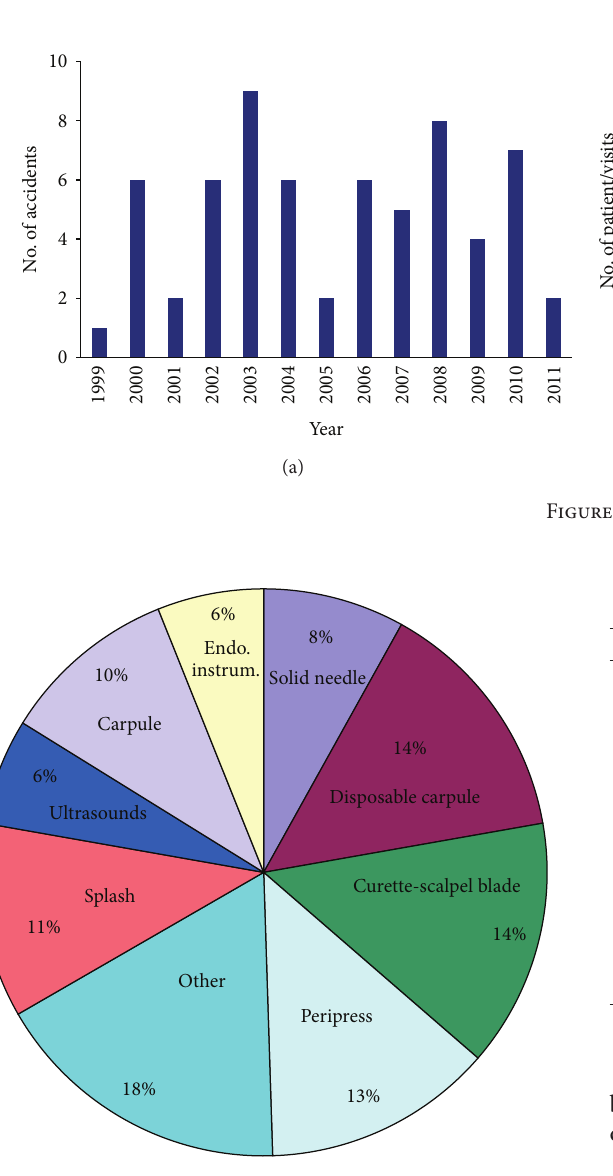
Figure 3: Instruments causing accidents, as percentages.